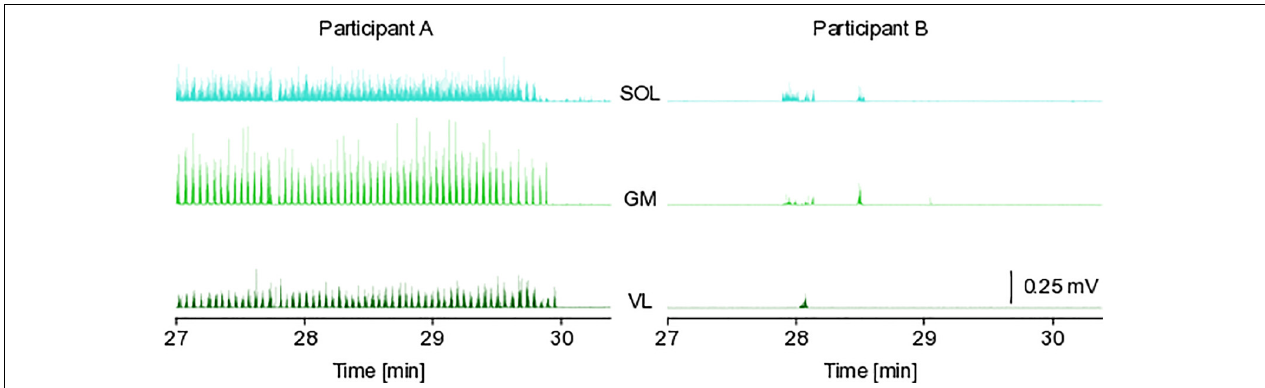
FIGURE 5 | Exemplary EMG data. The figure depicts exemplary electromyographic data from two participants (both cAG to facilitate the comparison) during the last 3 min of their 30 min centrifugation session. The data was recorded from the SOL, soleus; GM, gastrocnemius medialis; VL, vastus lateralis muscles. Participant A was almost constantly active, whereas participant B rarely contracted the leg